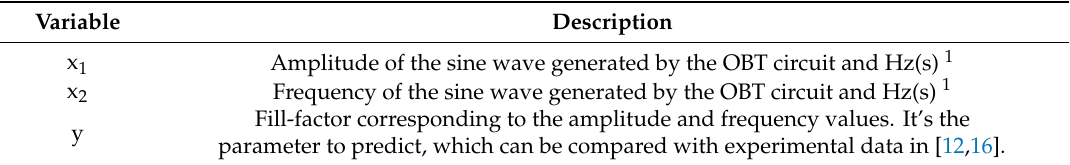
Table 1. Description of electrical and biological